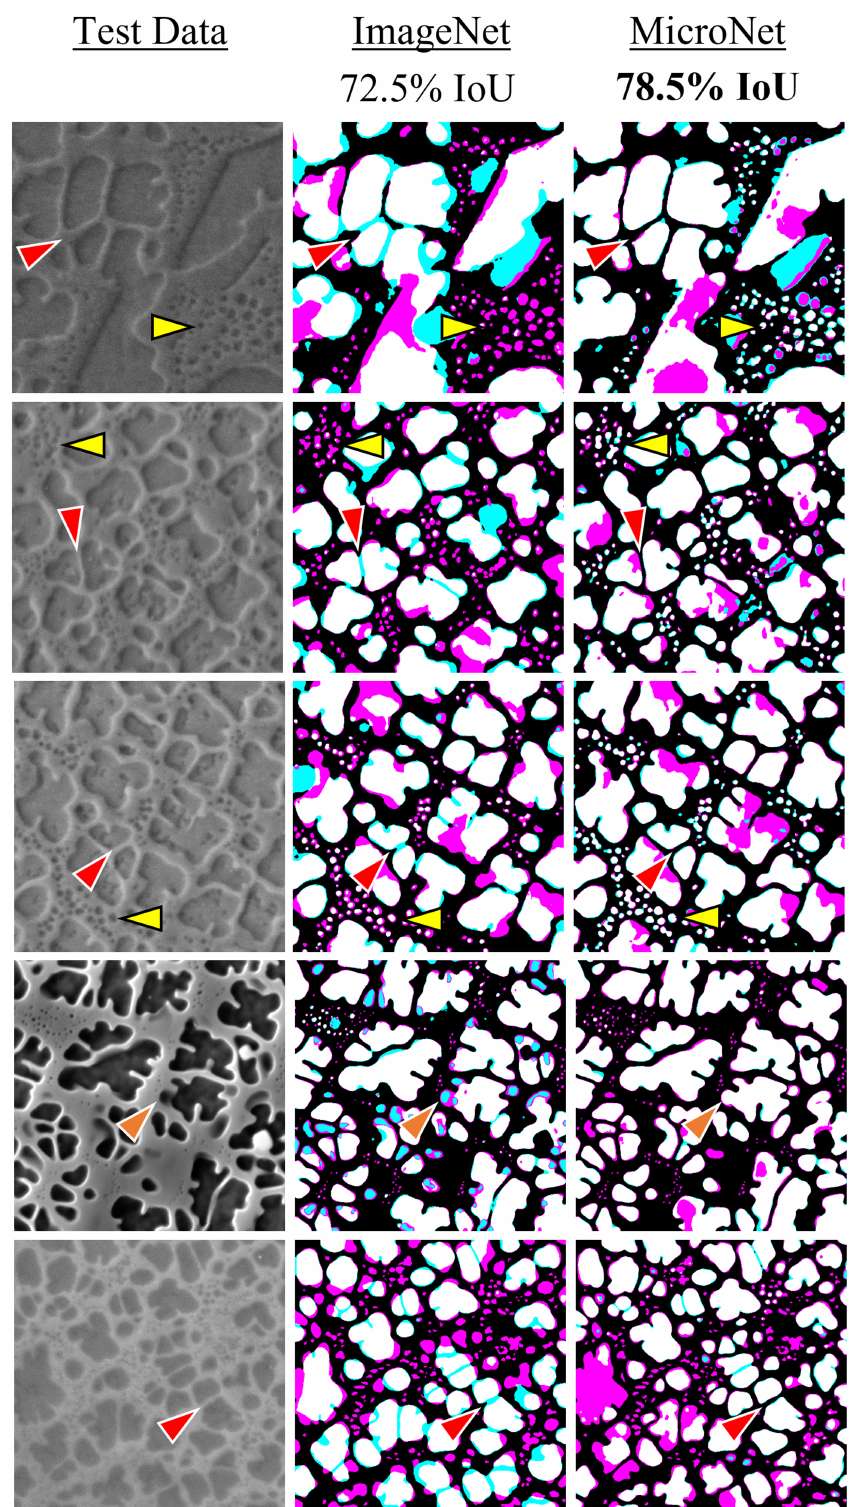
Fig. 4 Accuracy of Super-4 segmentation models evaluated on test data with unseen imaging conditions. The left column shows the images from the test set. The middle column shows the IoU accuracy masks for the best ImageNet model (UNet ++ , Ef fi cientNet-b0). The right column shows the same for best top MicroNet model (UNet, Ef fi cientNet-b1). Each row shows the test image and accuracy masks of the same image. The accuracy mask colors represent the same as in Fig. 3. The red triangles indicate example locations where the ImageNet model over-segmented and connected the tertiary precipitates which the MicroNet model accurately segmented. The yellow triangles indicate example locations where the ImageNet model failed to identify tertiary precipitates that the MicroNet model successfully identi fi ed. The orange triangles in the fourth row indicate one of many example locations where the ImageNet model improperly identi fi ed the corner of a secondary precipitate as a tertiary